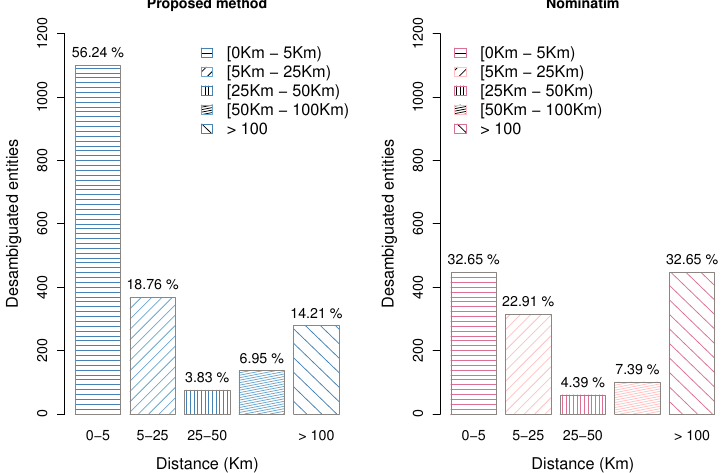
Figure 5. Frequencies of toponyms in ranges according to their distances to the actual points only for entities found in the